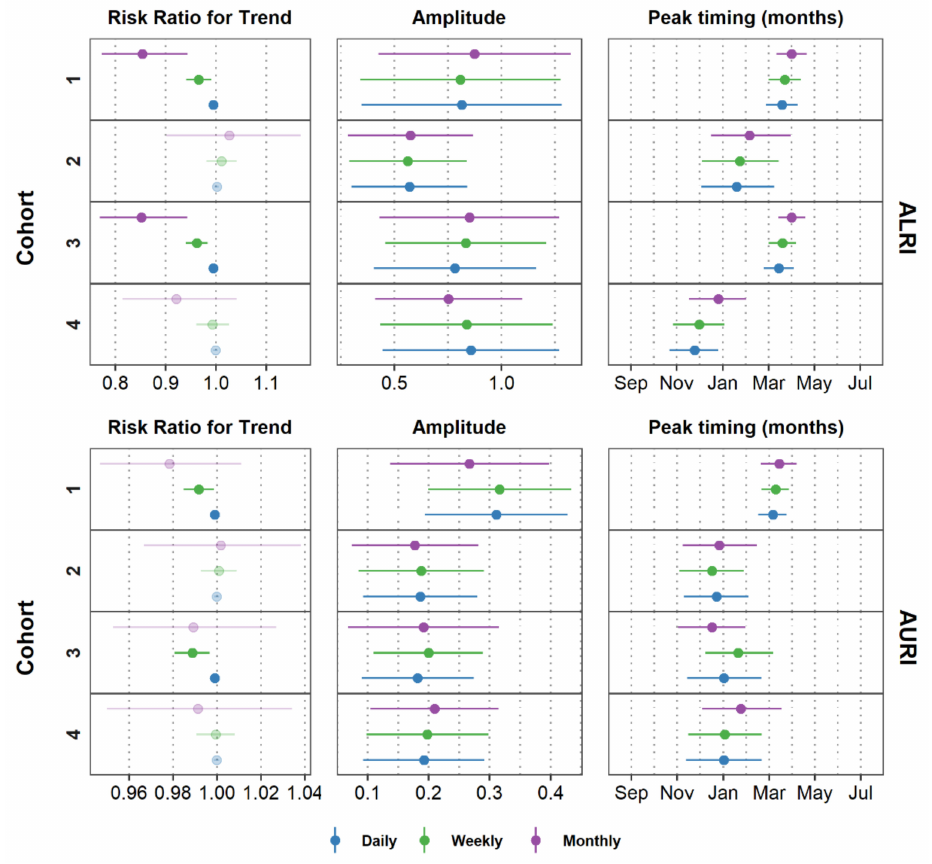
Figure A1. Trend and seasonal harmonics model fit results for daily, weekly, and monthly time series of ALRI and